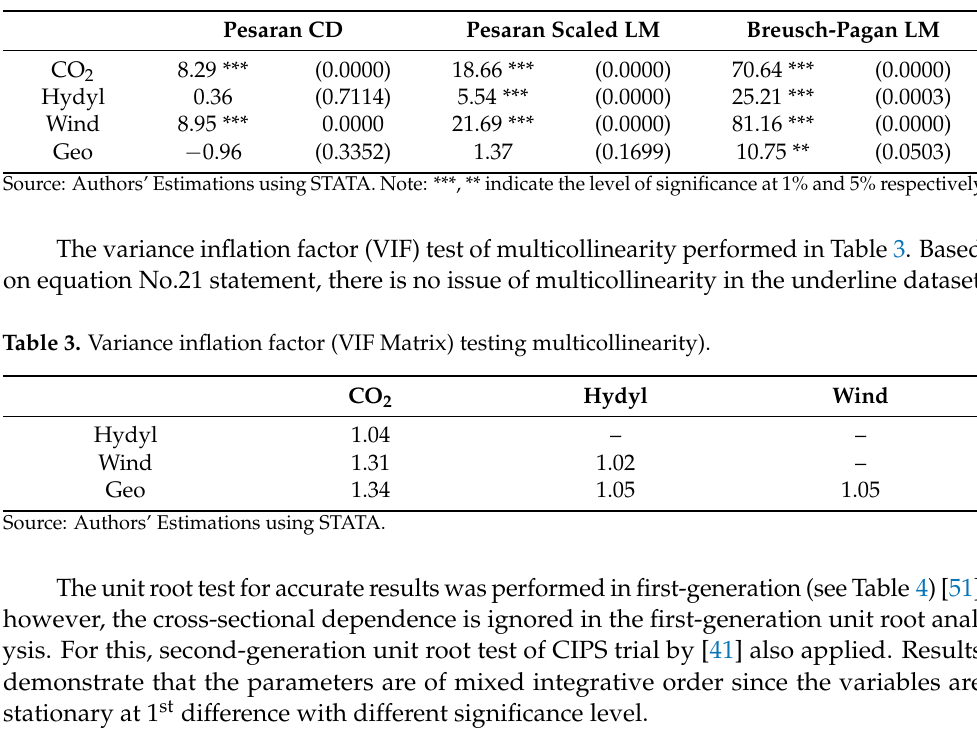
Table 2. Panel Unit Root Test for Cross-Sectional Dependence.